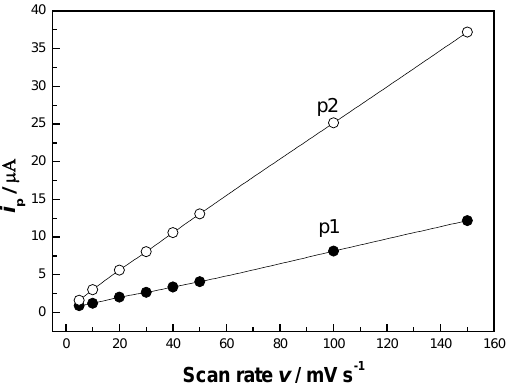
Figure 7. Plots of the anodic peak currents of 5.0 × 10 -7 M meloxicam at the cysteic acid/GCE in the B-R buffer solution (0.04 M, pH 1.86) at different scan rates. p1, the peak current at + 0.695 V; p2, the peak current at +1.088 V. Accumulation potential: -0.2 V; accumulation time: 300 s; quiet time: 30